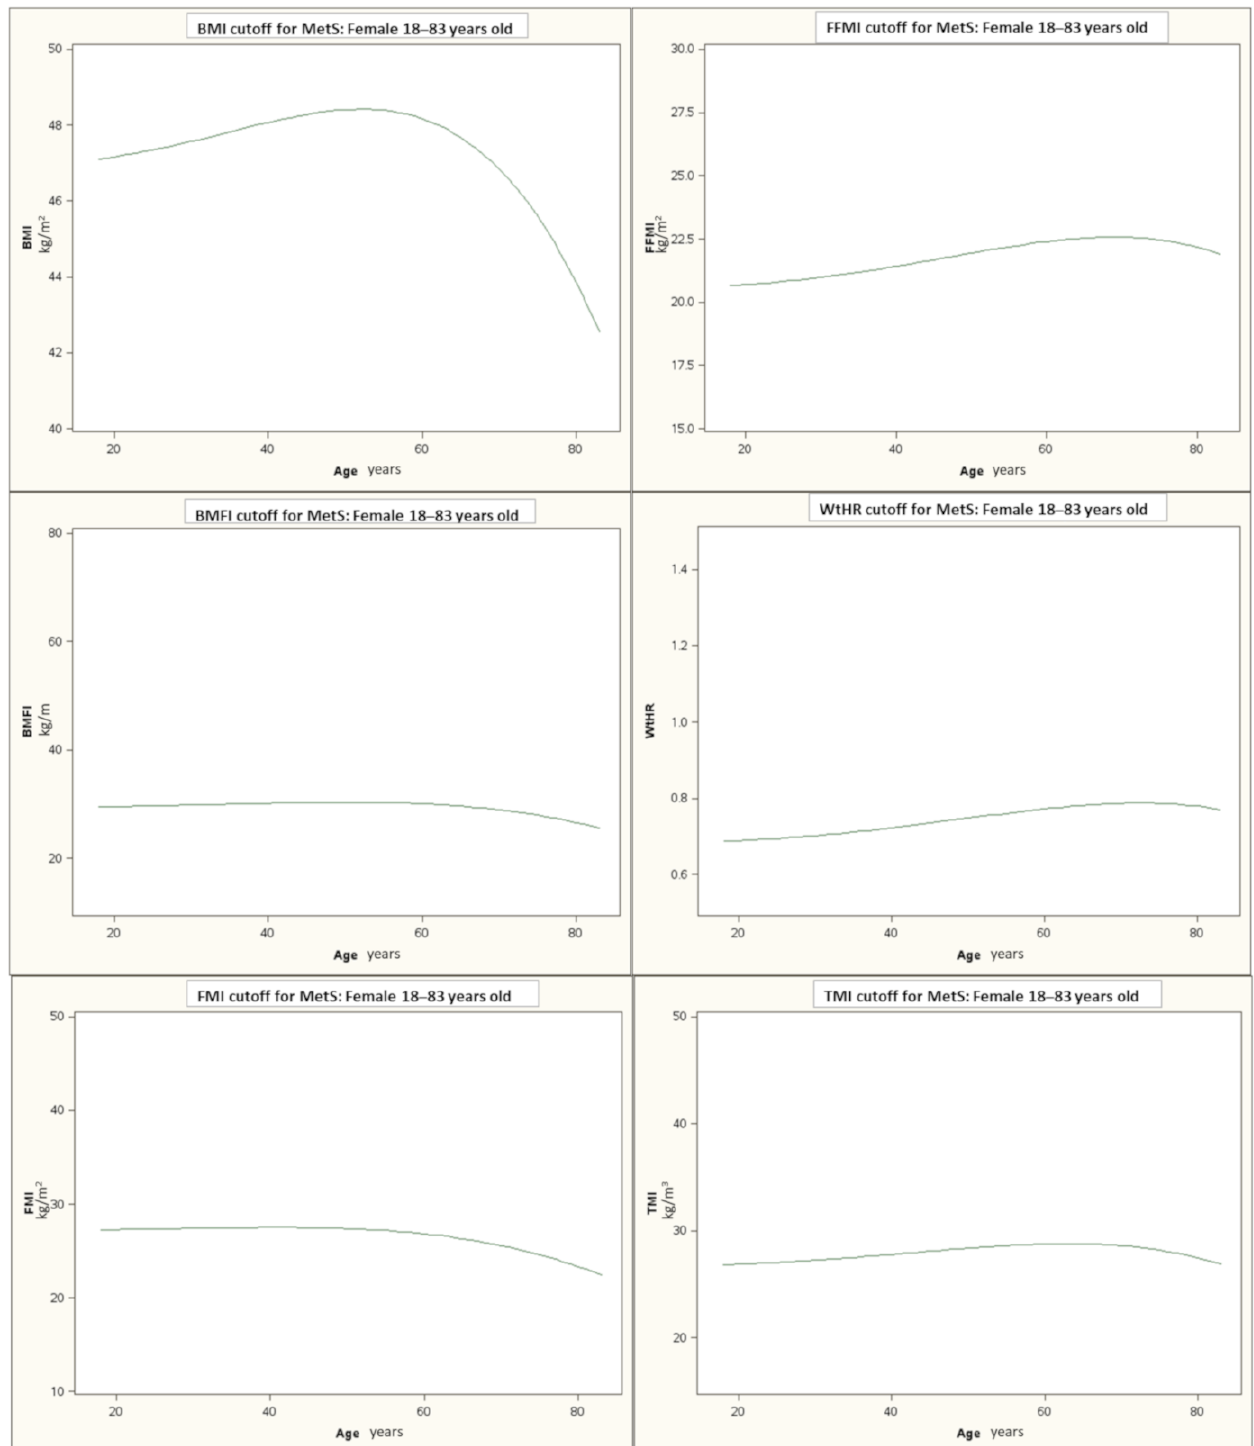
Figure 1. The threshold values of each index, beyond which the risk of METS is identified according to age. Abbreviations: BMI: body mass index; BMFI: body mass fat index; FMI: fat mass index; FFMI: fat-free mass index; WHtR: waist-to-height ratio; TMI: tri-ponderal mass